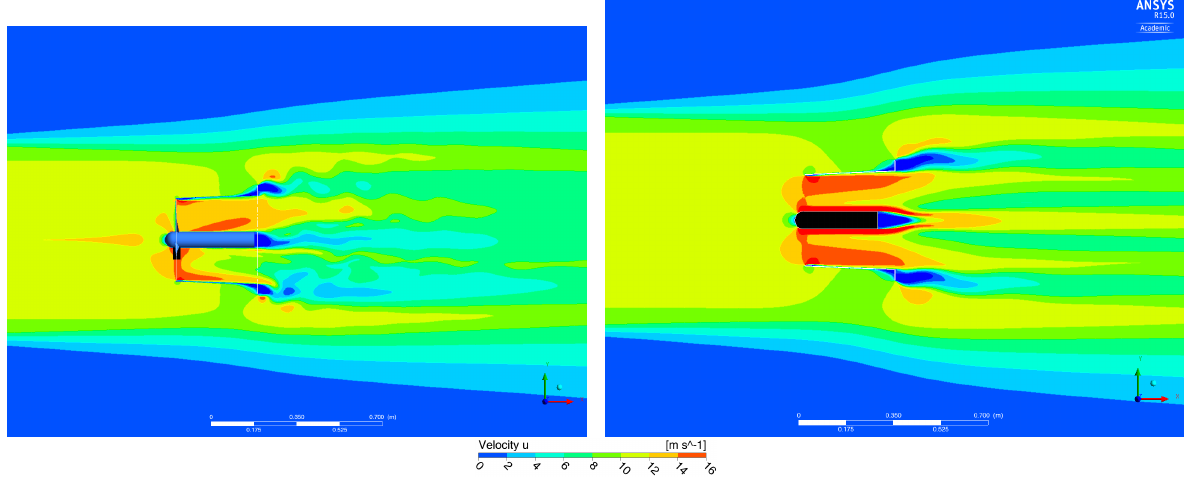
Figure 5: Streamwise velocity contours of the flow through the DAWT (streamwise section along the rotation axis) as seen from the FRM (a) and the ADM